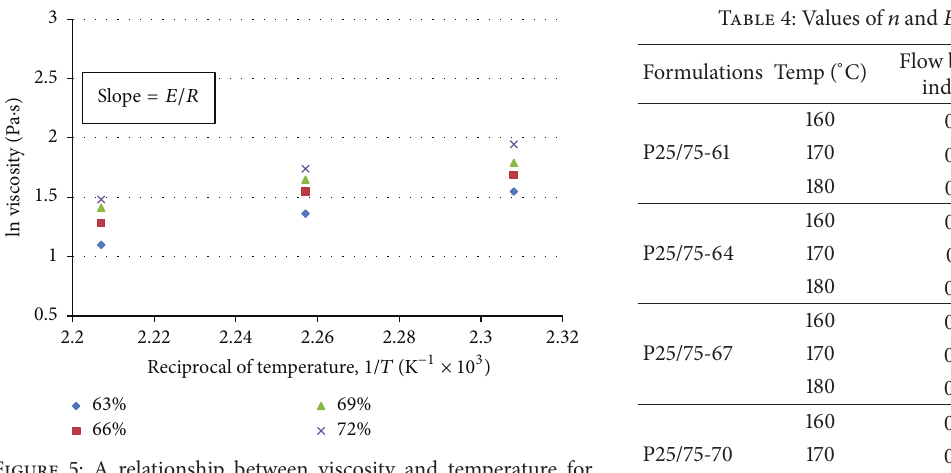
Figure 5: A relationship between viscosity and temperature for various PGA formulations.